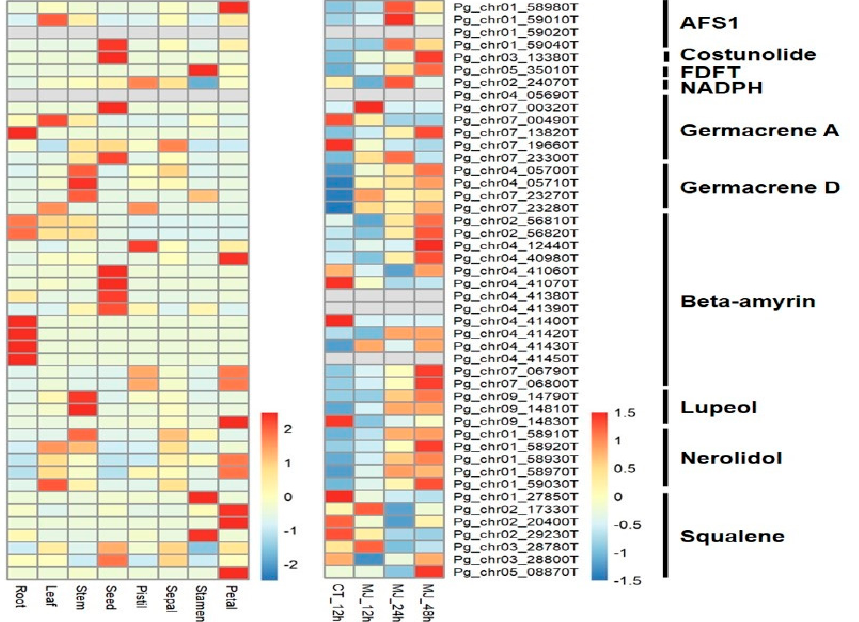
Figure 3. Expression patterns of candidate genes involved in the triterpenoid biosynthesis pathway in eight different tissues and three methyl jasmonate (MJ) treatments. Expression values were scaled per row (i.e., per gene) to visualize gene expression peaks among the different samples. Sample names and gene symbols are shown at the bottom and on the right of the heatmap, respectively. RNA sequencing data taken from the SRA database (https://www.ncbi.nlm.nih.gov/bioproject/526590, accessed on 12 December 2022). AFS1: alpha-farnesene synthase, FDFT: